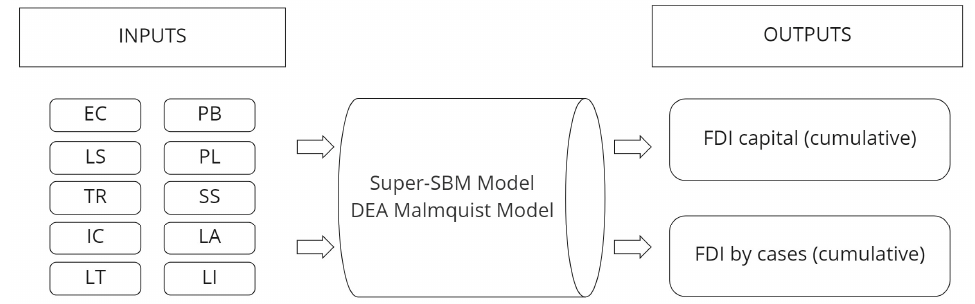
Figure 2. The DEA structure for evaluation of FDI attractiveness in Vietnam.